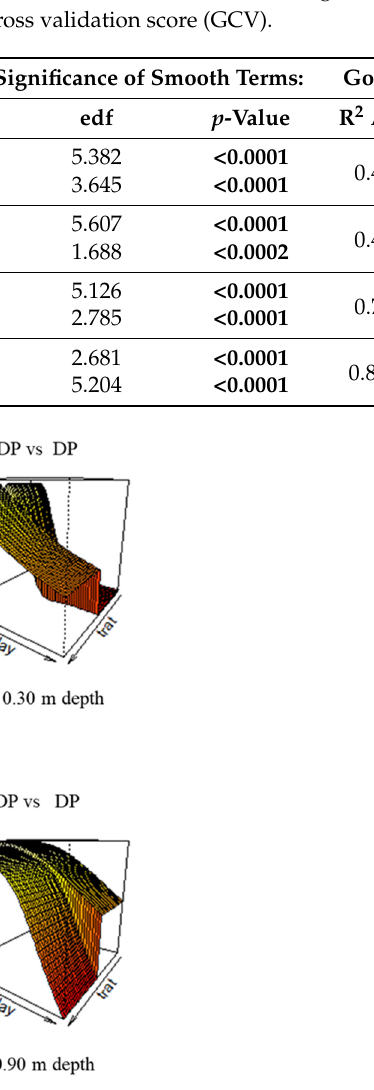
Figure 6. Gam model trend surface at the four soil depths: 0.10 m; 0.30 m top left and right ; 0.60 m and 0.90 m bottom left and right . The three-dimensional graphs show the model predicted values of volumetric water content: y -axis «linear predictor»), for the two clipping regimes: z -axis «trat» for unclipped (NDP) (foreground) and dual purpose (DP) (background) during the reproductive stage ( x -axis «day»). Records from 17 April–7 June